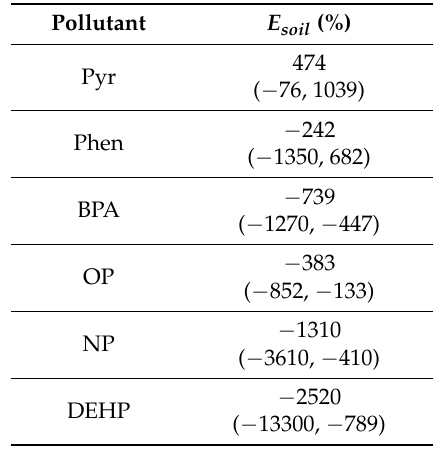
Table A9. Percent difference between the change in pollutant mass recovered in the system at the end of the period compared to the mass of pollutant intercepted ( E soil ) for all pollutants. Median and 95% confidence interval are presented.